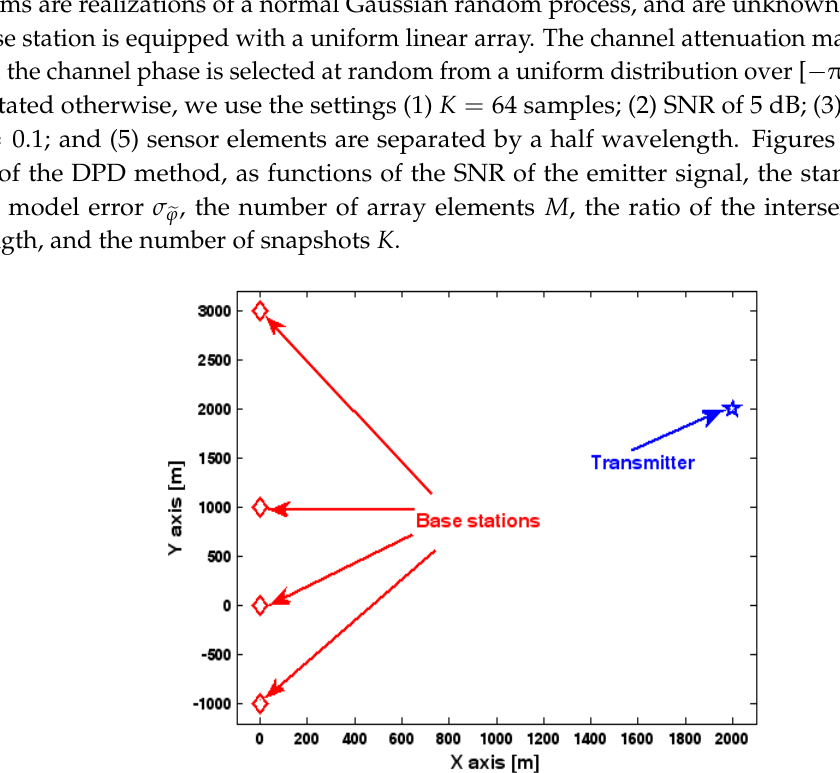
Figure 1. Location geometry for simulation.